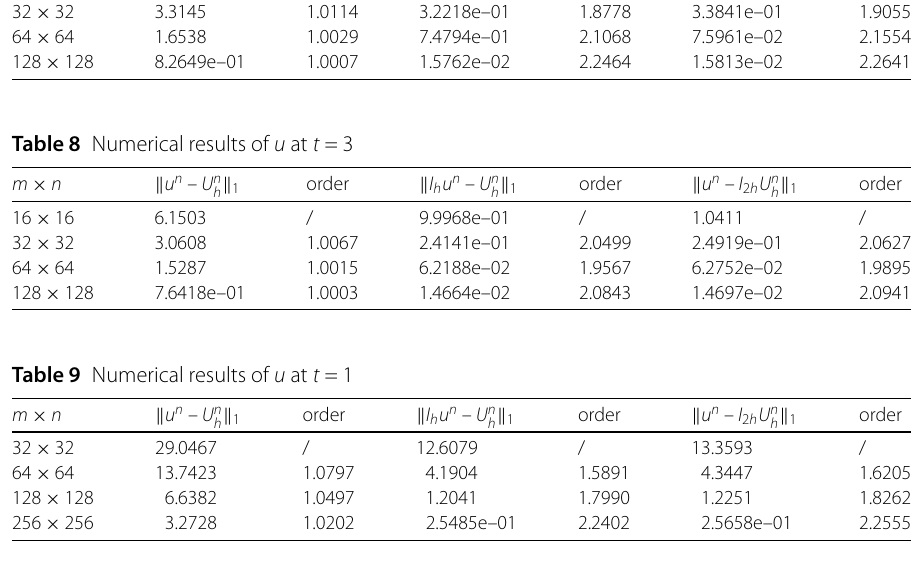
Table 10 Numerical results of u at t = 2 m × n